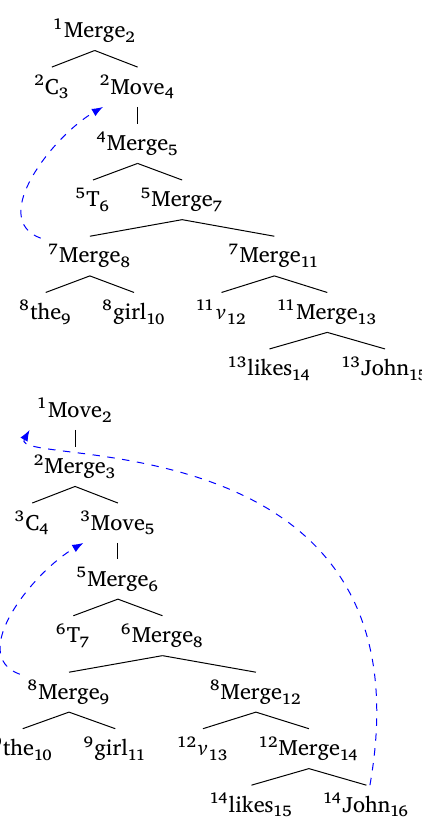
Standard recursive descent works for MG derivation trees only if Move does not alter the precedence relations